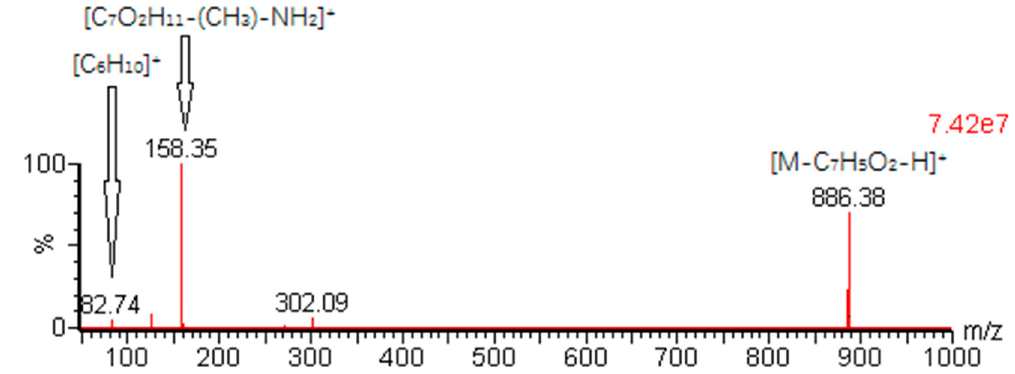
Figure 1. Mass spectrum of emamectin by product scan.